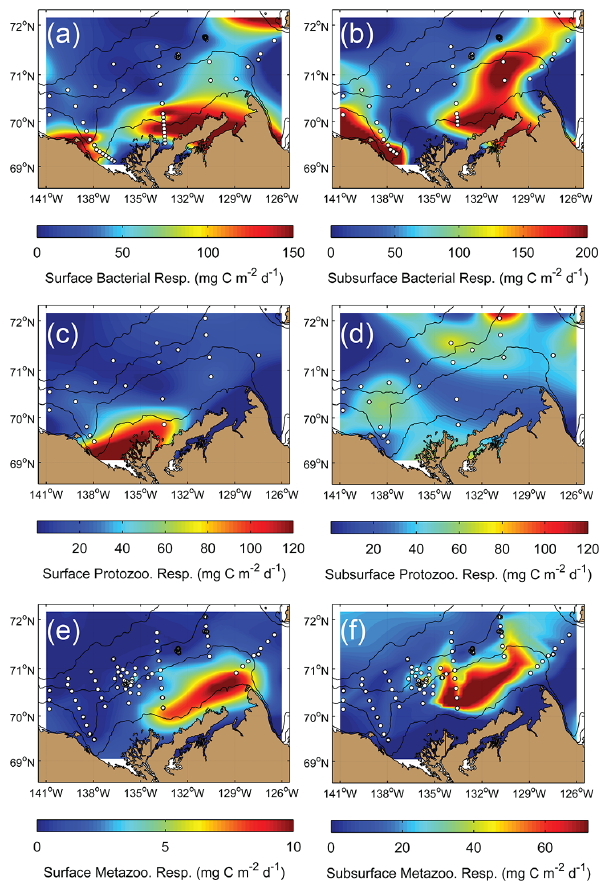
Figure 8. Gridded composites of estimated values related to het- erotroph respiration in the surface (left panels) and subsurface (right panels) layer: (a, b) bacterial respiration, (c, d) protozooplankton respiration, and (e, f) metazooplankton respiration. The white dots correspond to the sampling stations upon which respiration esti- mates were calculated. For a detailed description on how each res- piration flux has been estimated, please see Sect. 2.6.